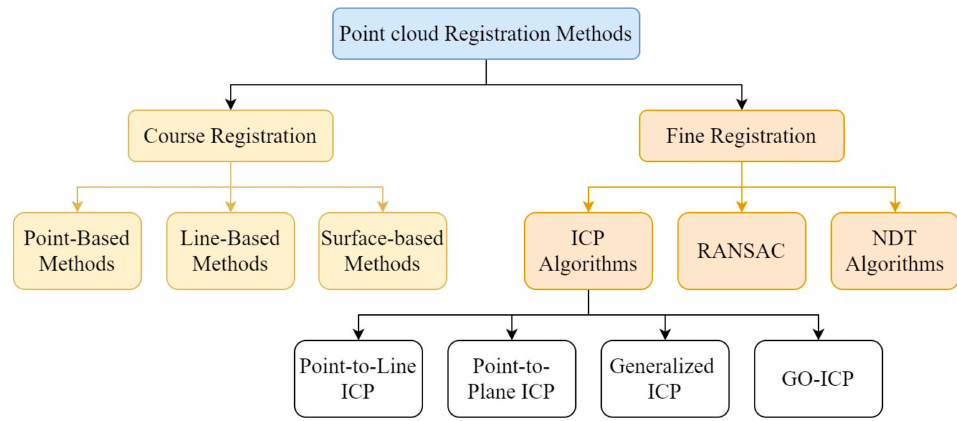
Figure 7. Taxonomy of classical registration methods for 3D point